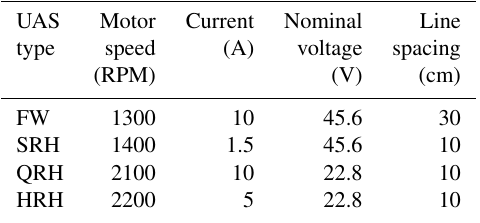
Table 3. UAS mapping